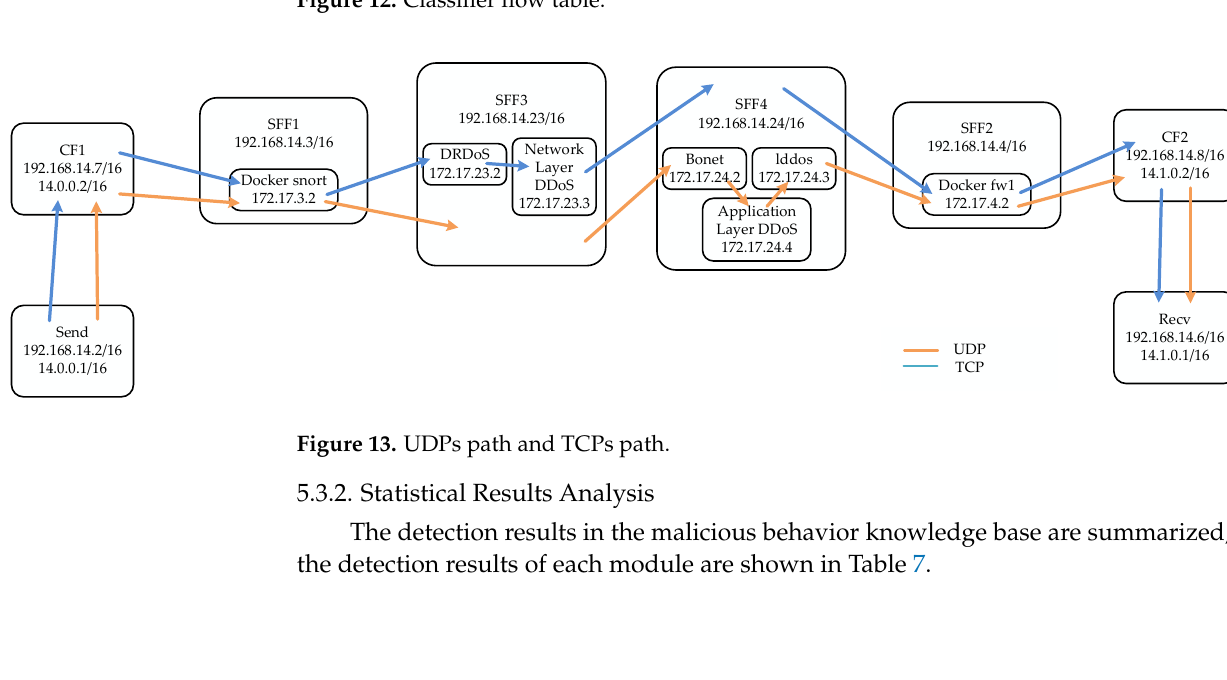
Figure 12. Classifier flow table.